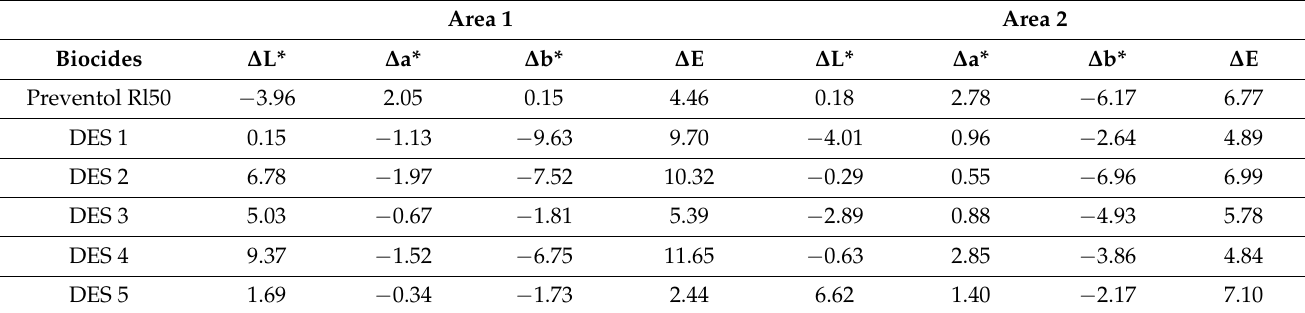
Table 3. Colorimetric parameters ( ∆ L*, ∆ a*, ∆ b*, and ∆ E) of Area 1 and Area 2. Area 1 Area 2